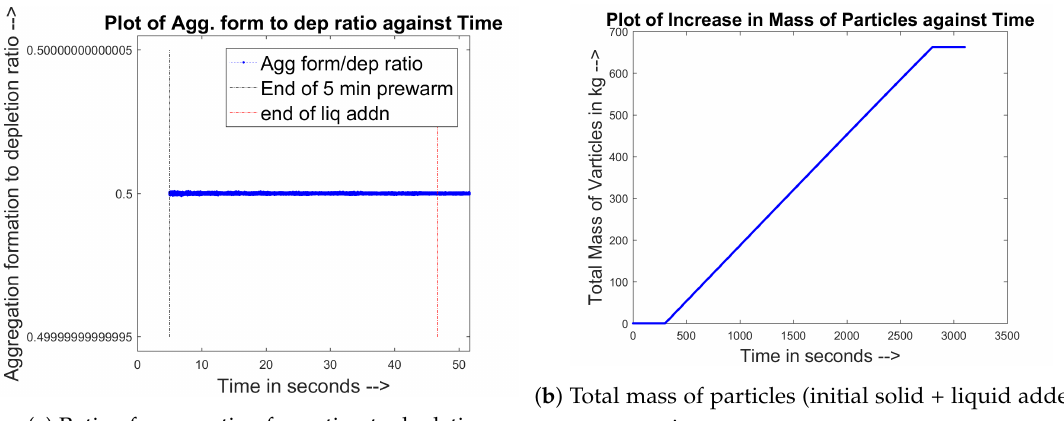
Figure 6. Plots showcasing the veracity of the results obtained from the integrated population balance, energy balance, binder dissolution and viscosity prediction